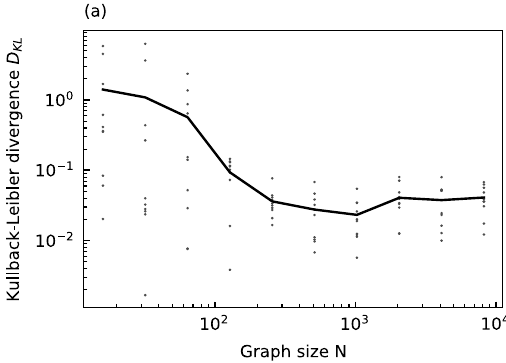
independent samples forthegraphsin a withthe Metropolis –